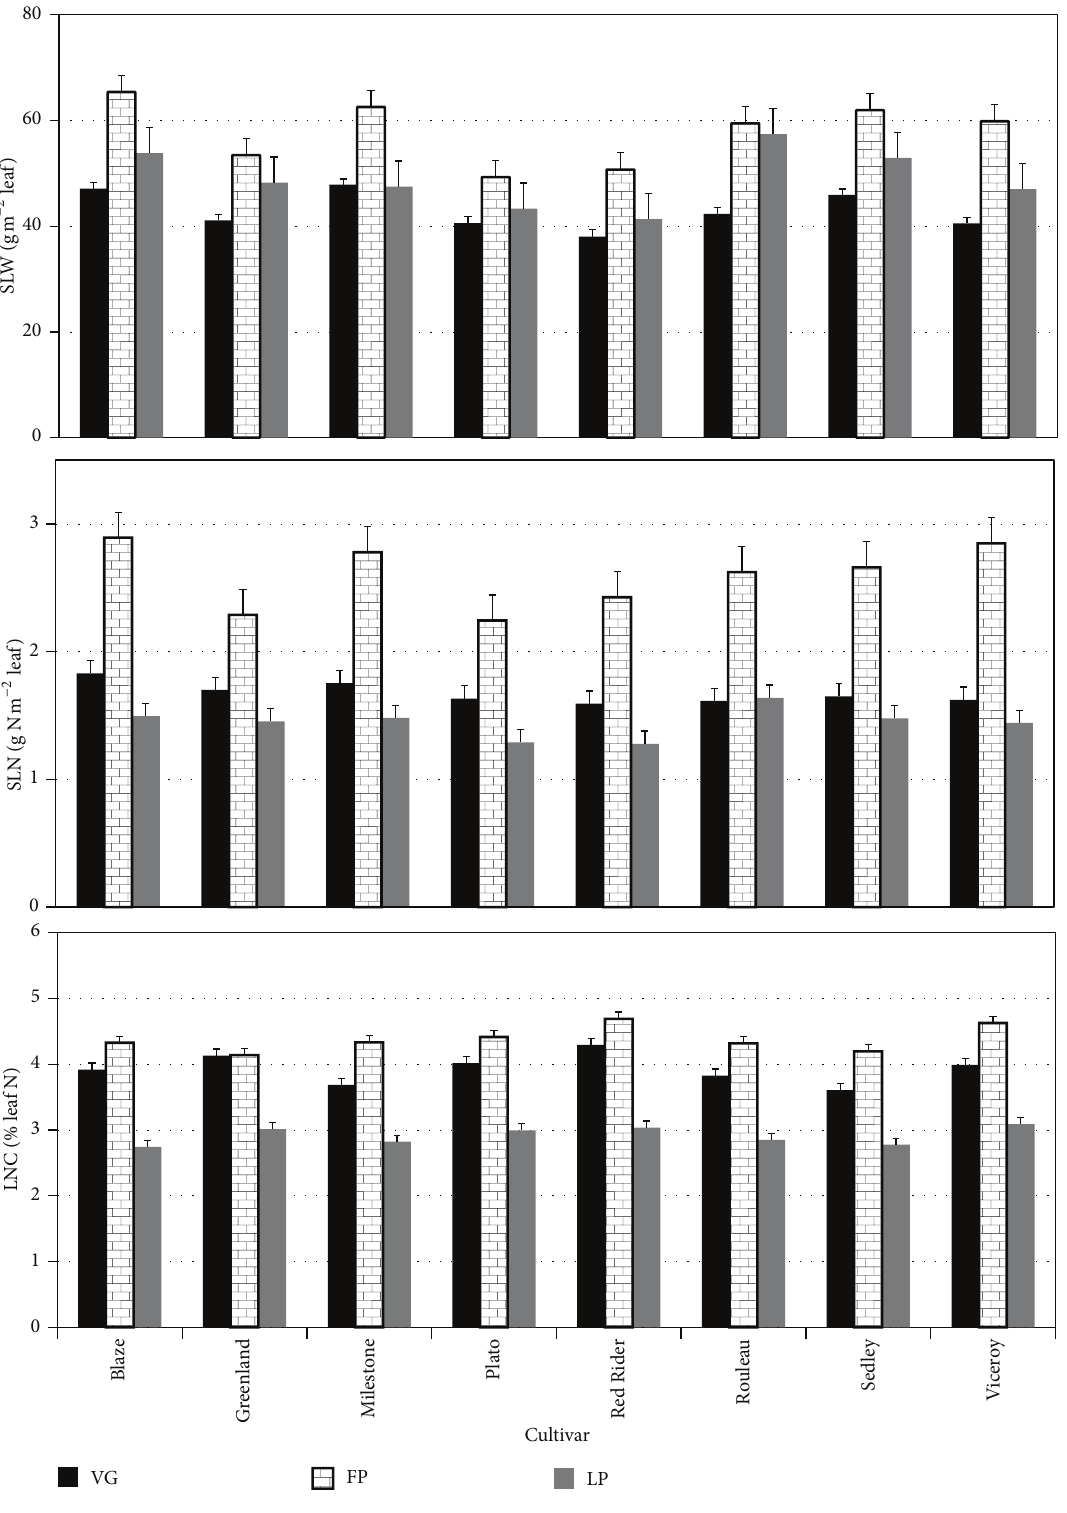
Figure 1: Variations of eight lentil cultivars for specific leaf weight (SLW), specific leaf N (SLN), and leaf N concentration (LNC) at three growth stages of vegetative (VG), first-pod (FP), and late-pod (LP) stages in the N fertility trial in 2007. Error bars are standard